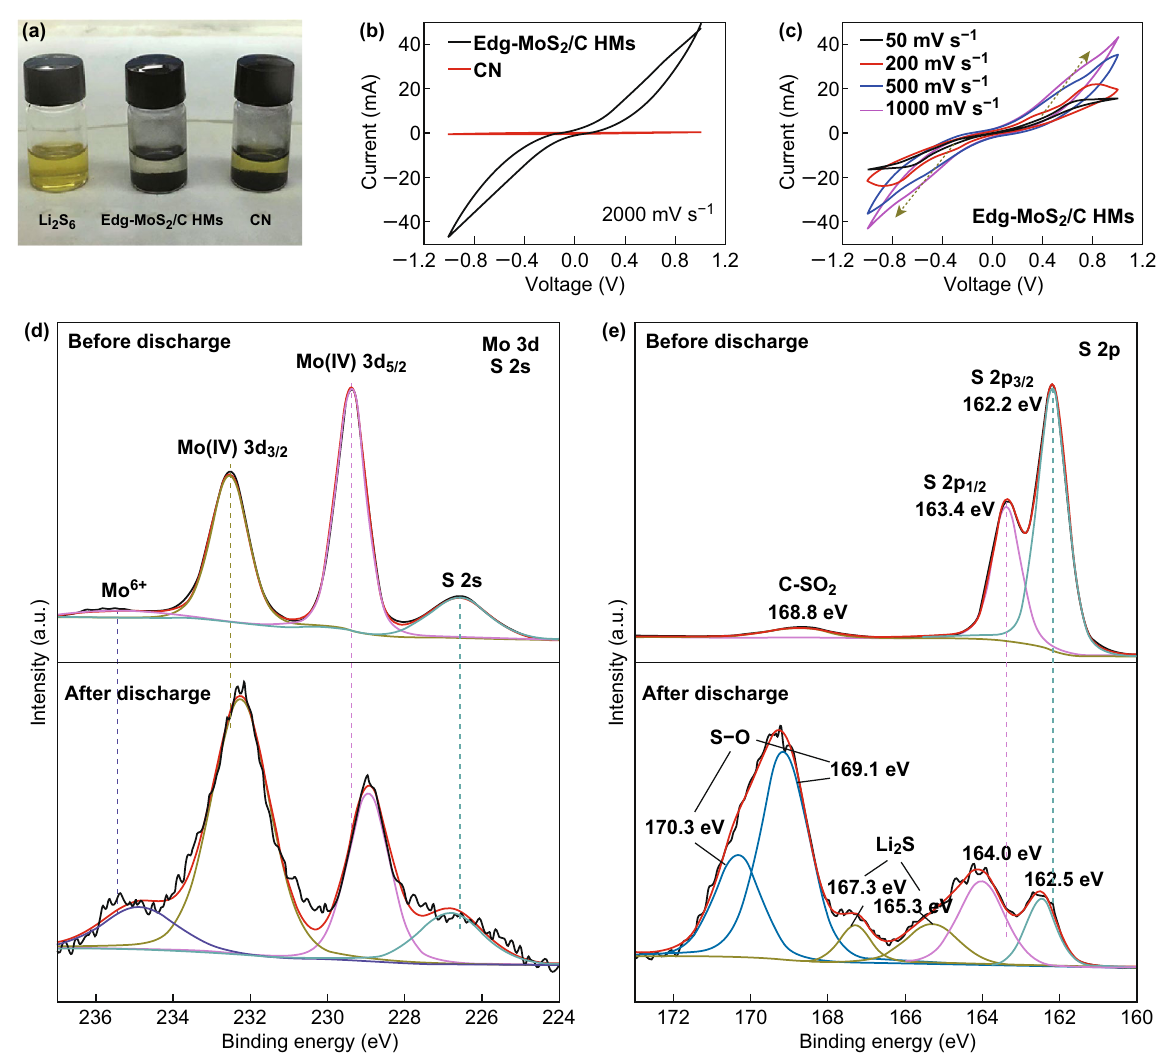
Fig. 4 Investigation of the mechanism of interaction between the Edg‑MoS 2 /C HMs and sulfur species during the redox reactions of the Li–S cells. a Visual adsorption tests of Li 2 S 6 by pristine Edg‑MoS 2 /C HMs and CN. b CV curves of symmetric dummy cells employing Edg‑MoS 2 /C HMs and CN electrodes at a high scan rate of 2000 mV s −1 . c CV curves of the Edg‑MoS 2 /C HMs symmetric cells at different scan rates. d The Mo 3 d , S 2 s , and e S 2 p spectrum of the Edg‑MoS 2 /C‑functionalized separator before and after the first 100% discharge at 0.05